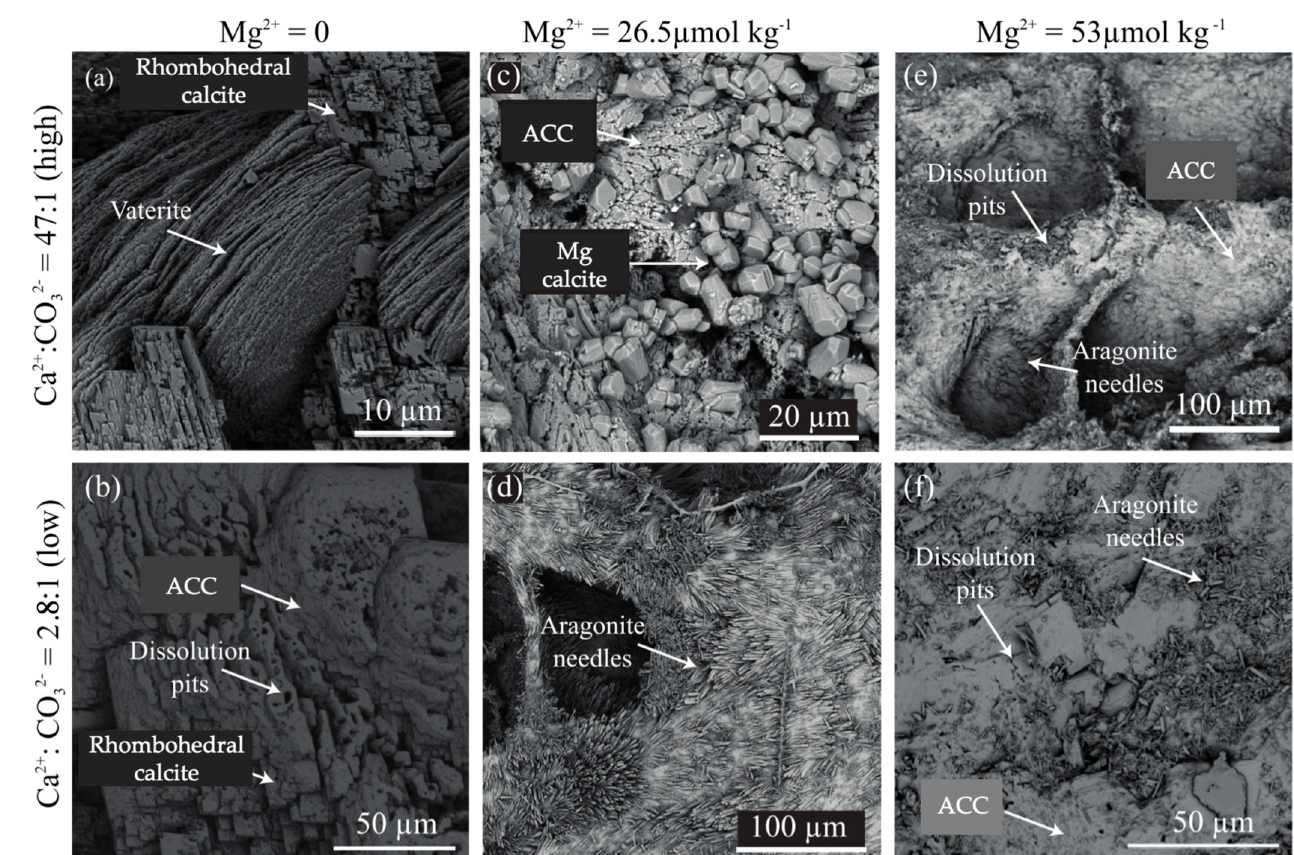
Figure 4. Representative SEM images of the precipitated CaCO 3 from each experimental scenario. This shows the influence of Ca:CO 3 stoichiometry, as well as the Mg concentration on the CaCO 3 morphology. The Mg-free incubations with a 47:1 Ca:CO 3 ( a ) resulted in crosshatched vaterite and layered rhombohedral calcite. Mg-free incubations (control Mg treamtent) with a 2.8:1 Ca:CO 3 stoichiometry ( b ) resulted in an intermediate form of ACC together with rhombohedral calcite and some signs of dissolution. Where the Mg concentration was half that of the modern seawater values (26.5 mM) and with a 47:1 Ca:CO 3 stoichiometry ( c ) resulted in a Mg-calcite structure c.f. [48]. Mg concentration of 26.5 mM with a 2.8:1 Ca:CO 3 stoichiometry ( d ) resulted in the formation of aragonite needles. In the scenario where the Mg concentration was 53 mM (equivalent to modern seawater values) no matter if the Ca:CO 3 stoichiometry was 2.8:1 or 47:1 ( e , f ) very little new CaCO 3 material precipitated, instead we can see ACC with low relief aragonite needles or unconnected aragonite needles and dissolution pits.